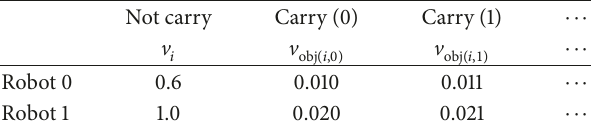
Table 6: Moving velocity (object ID in brackets).